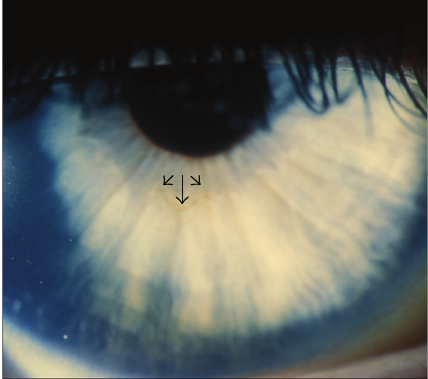
Figure 1: Line of corneal pigmentation